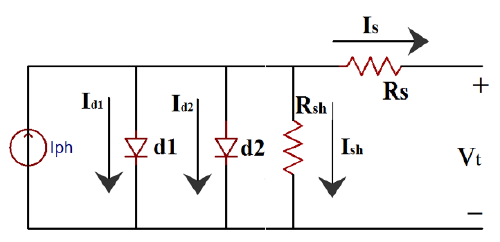
Figure 2. Double-diode